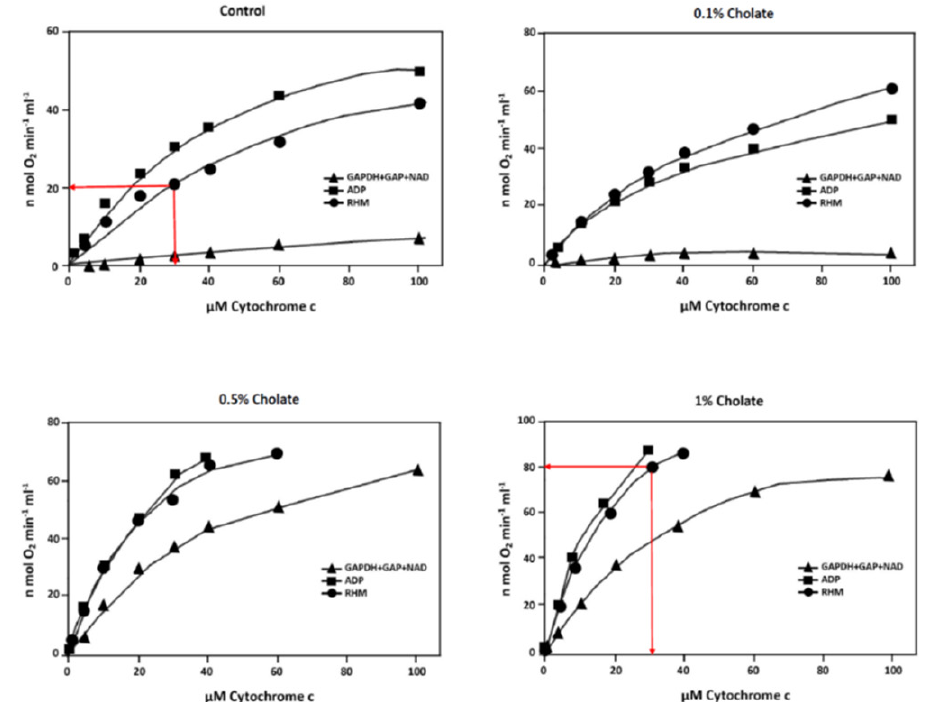
Figure 5. Effects of different cholate concentrations on the activity and allosteric ATP-inhibition of CytOx in isolated intact rat heart mitochondria (RHM). Mitochondria (30 µ g/mL) were titrated with increasing concentrations of cytochrome c in a medium containing 250 mM sucrose, 10 mM Hepes, 5 mM MgSO 4 , 5 mM potassium phosphate, 0.5% BSA (fatty acid-free), 0.2 mM EDTA, pH 7.2. Where indicated, 5 mM ADP was added. High ATP/ADP ratios were established by the addition of 5 mM ATP and the ATP-regenerating system: 1.2 mM GAP + 100 units/mL GAPDH + 1 mM NAD + (GAPDH + GAP + NAD). In comparison to control, the oxygen consumption at 30 μ M cy- tochrome c increases from 20 to 80 nmole O 2 x min − 1 x ml − 1 in the presence of 1% cholate without any additions (red arrows).